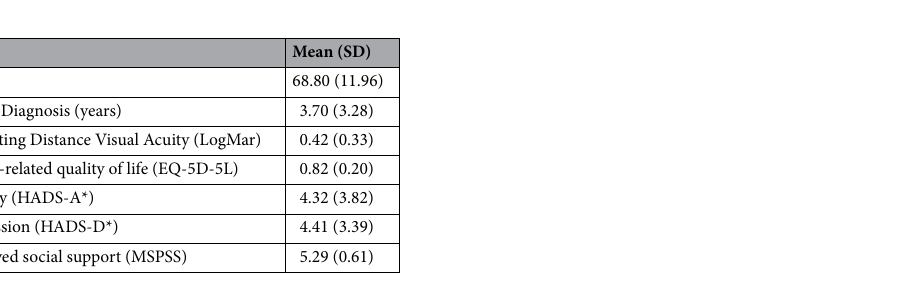
Table 1. Demographic and clinical data. EQ-5D-5L EuroQol Questionnaire of health-related quality of life, HADS Hospital Anxiety and Depression Scale, MSPSS Multidimensional Scale of Perceived Social Support. *Raw